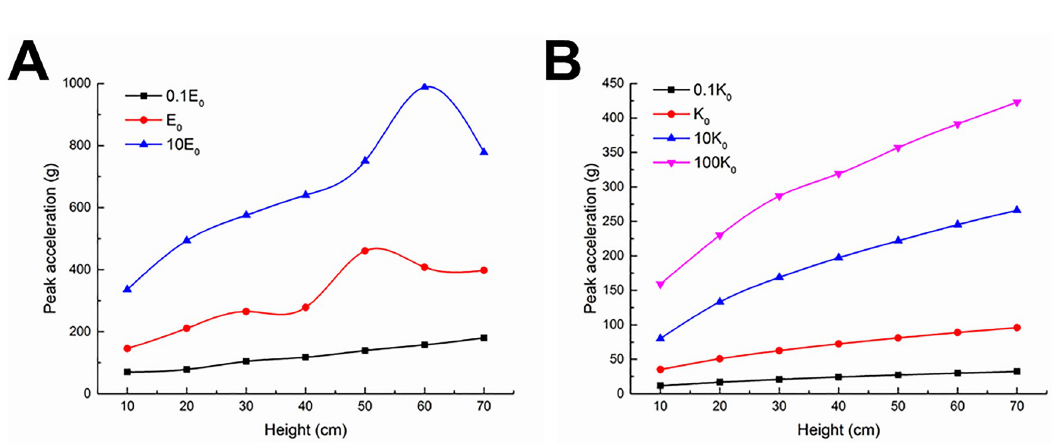
Fig 6. Results of sensitivity analyses in the FEM simulations. Effects of (A) elastic modulus and (B) spring stiffness coefficient.